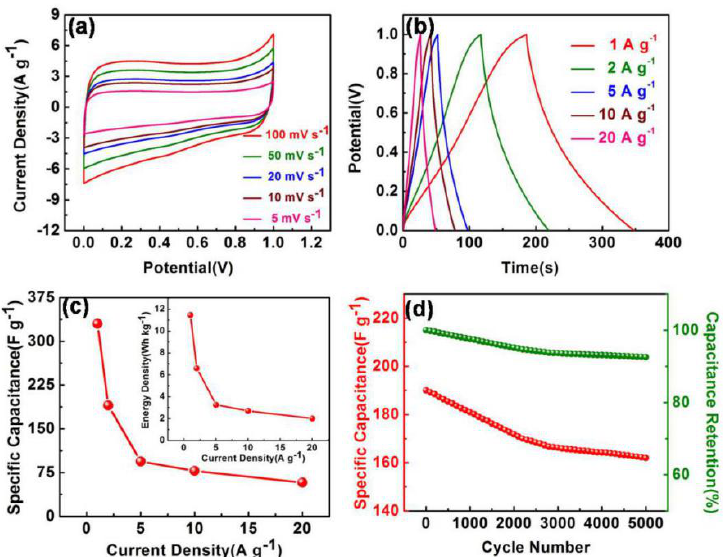
Figure 6. Electrochemical performances in a two-electrode system, 6 M KOH aqueous solution used for the electrolyte. ( a ) CV curves and ( b ) GCD curves of the device at different scan rates and current densities, respectively. ( c ) Energy densities and specific capacitance of AAWHC at different current densities. ( d ) Cycling stability at 2 A g − 1 (5000 cycles).